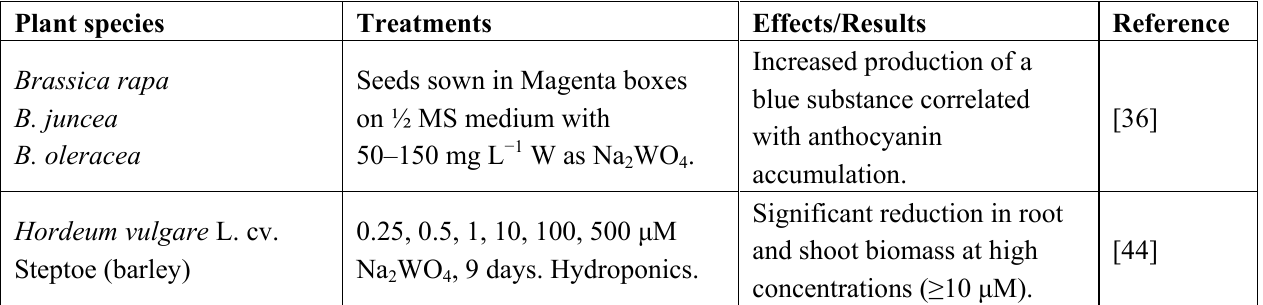
Table 1. Macroscopic effects of W in higher